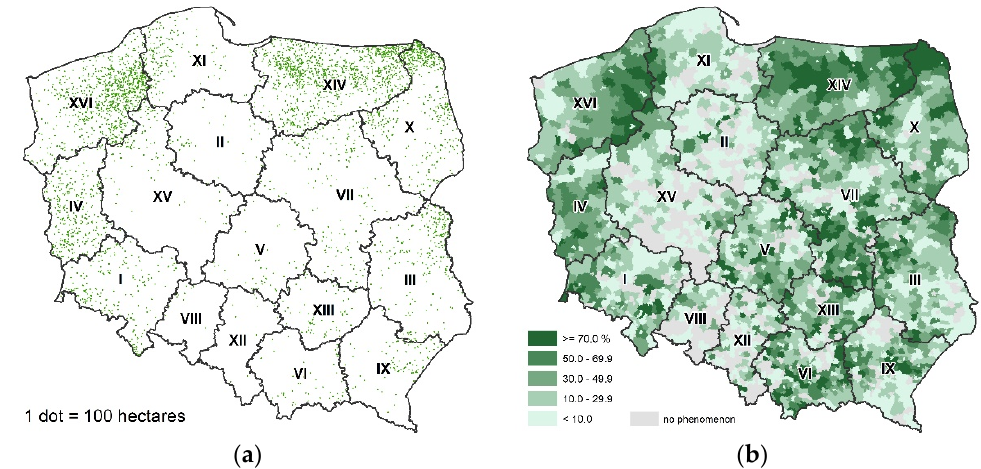
Figure 3. Area of land subsidised for organic farming in ha ( a ), and its share in total area of land covered by pro-environmental RDP support ( b ). Source: own elaboration.